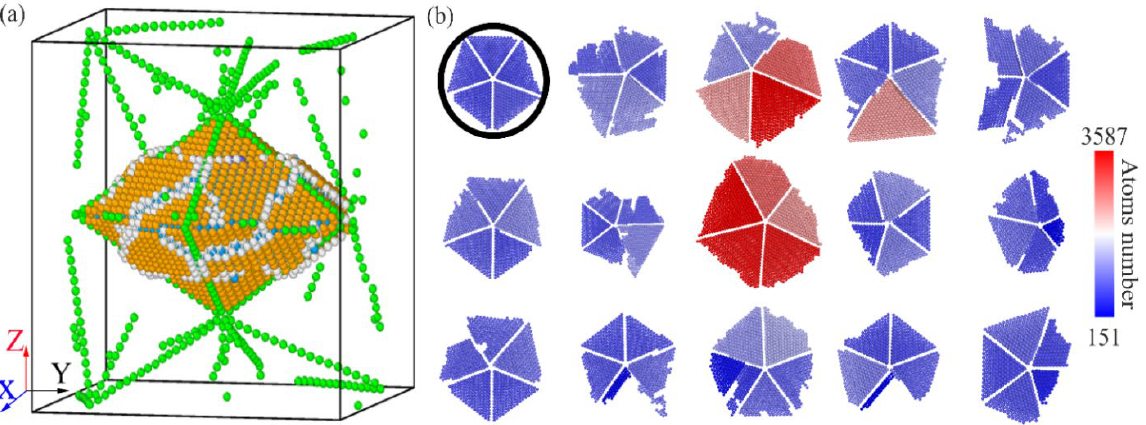
Figure 3. ( a ) TDH atoms (green) around the initial penta-twinned structure and the multi-twinned regions formed by FCC tetrahedron structures. Atoms of other structures are marked white. Atoms in ( b ) are colored based on the atom number of each cluster.